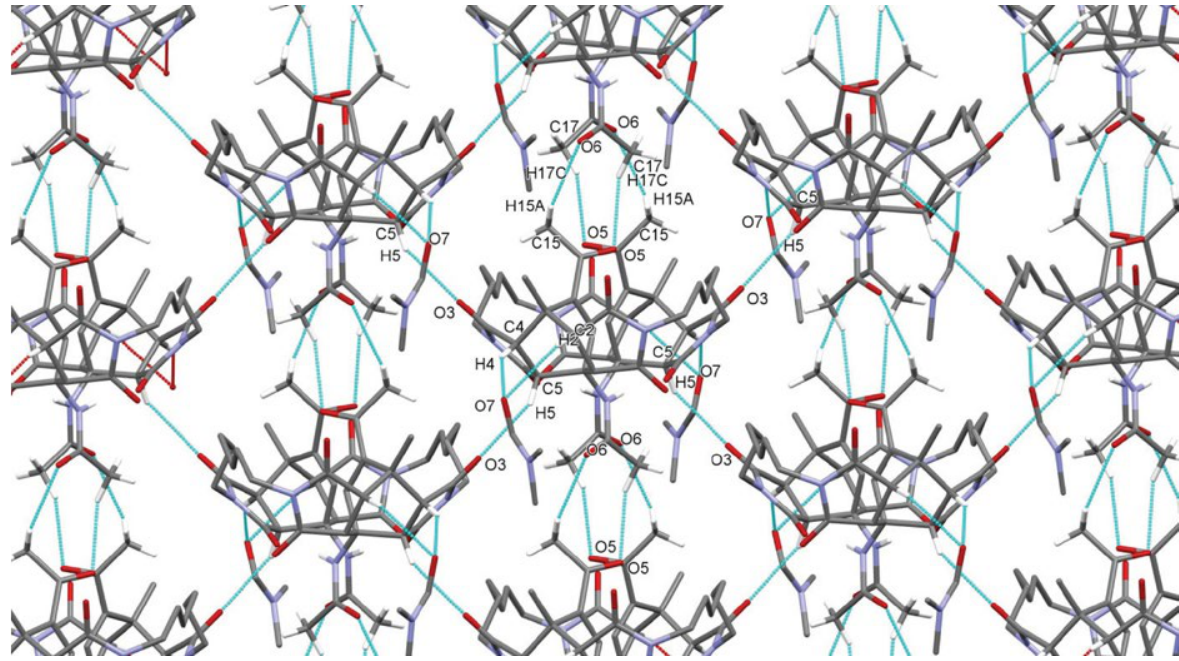
Figure 6. 2D layer formation in 3 generated by C–H···O hydrogen bonding (blue dashed lines). Hydrogen atoms not involved in the motif shown have been omitted for